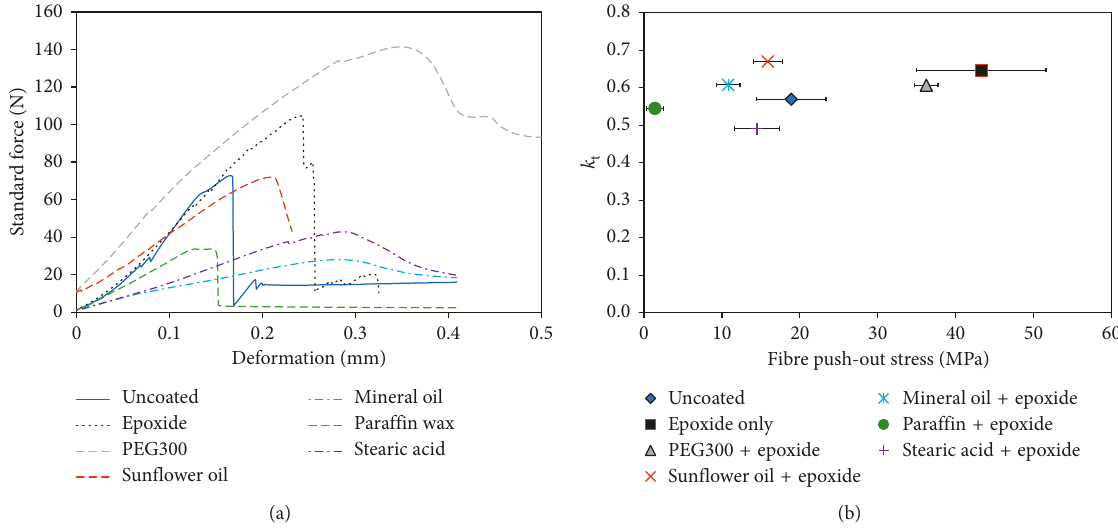
Figure 9: (a) The fibre push-out force and deformation graphs for representative single fibres and (b) the fibre push-out test results vs the electromechanical coupling factor ( k t ) for the PZT-based composite fibres and discs with fibres dip coated in various soft